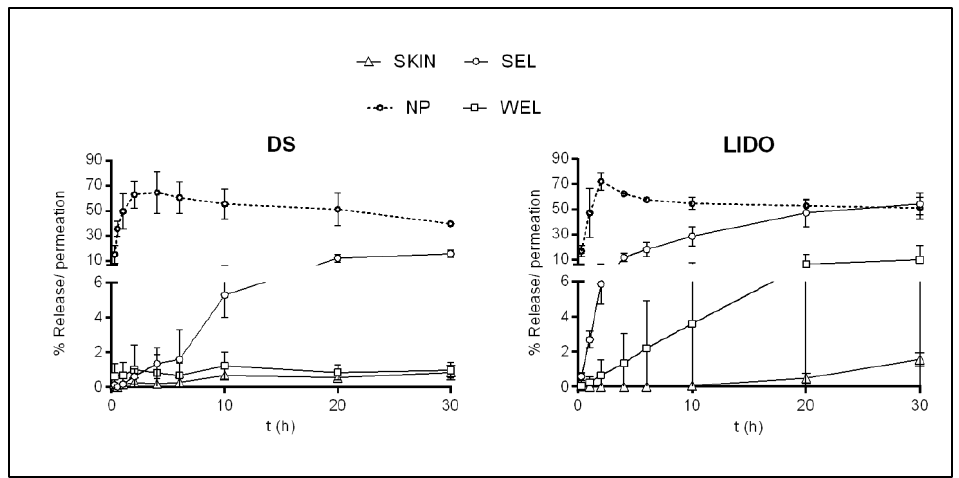
Figure 2. Average percentage release of lidocaine (LIDO) and diclofenac sodium (DS), through Nuclepore ® , 5% SEL and 5% WEL membranes and average percentage permeation of these compounds through the skin.